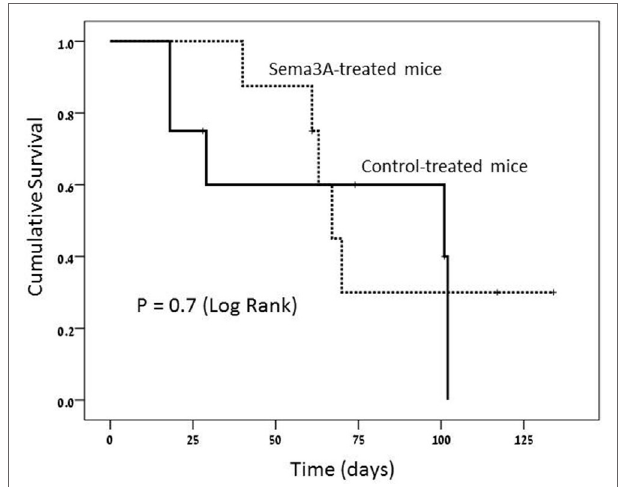
mice when compared to that of sema3A-treated mice. In this case, we could not show statistical significance due to the small